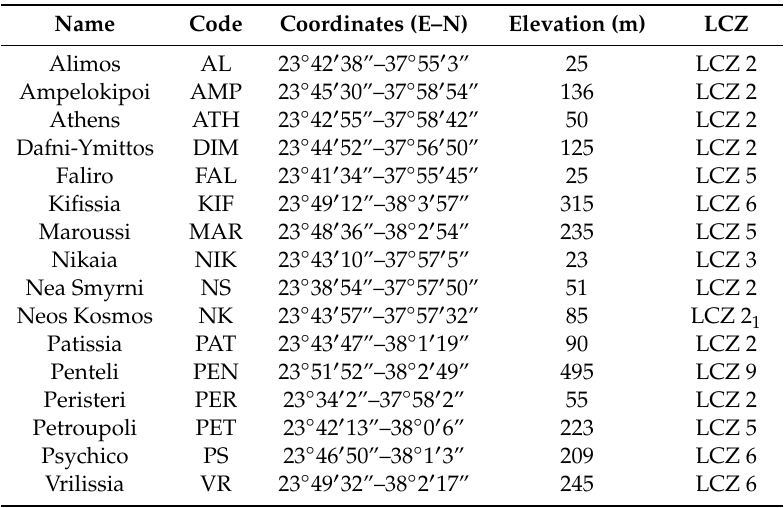
Table 3. The automated weather stations used in this study for the evaluation of WRF; source